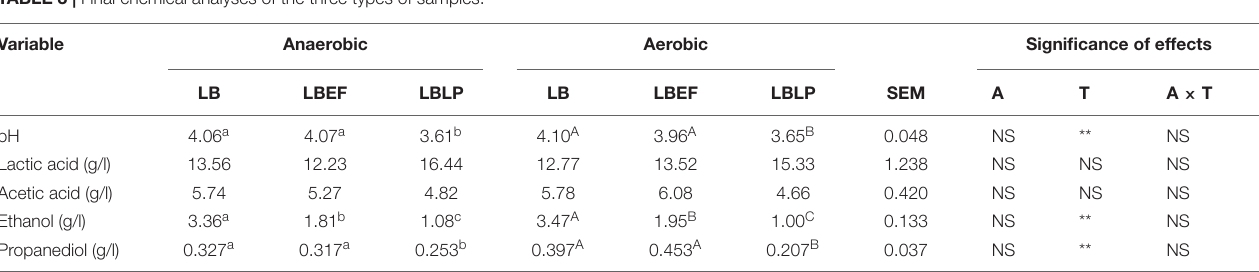
TABLE 3 | Final chemical analyses of the three types of